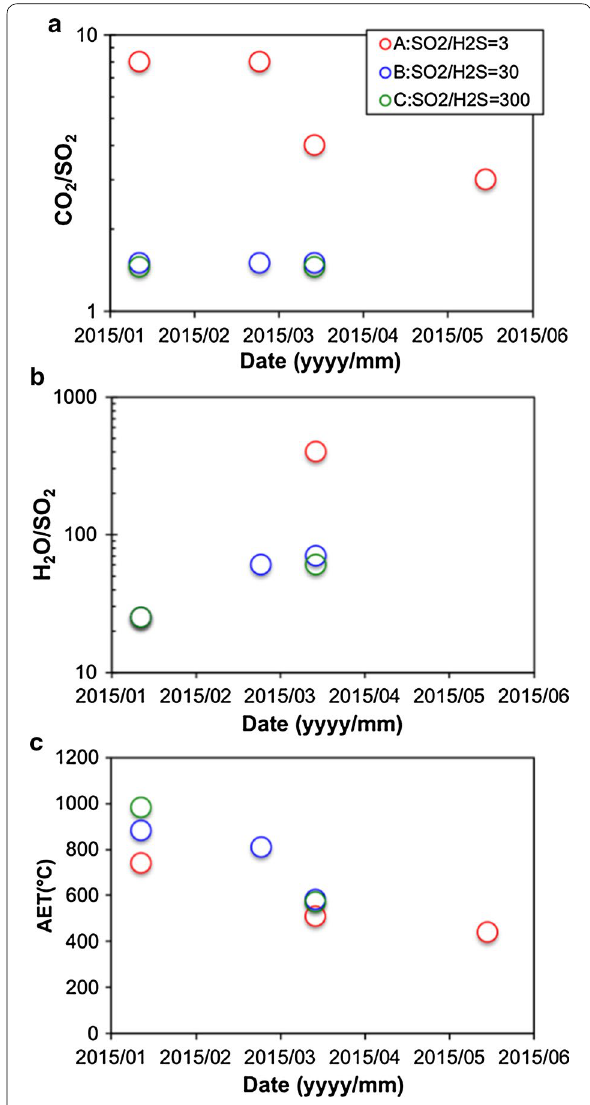
Fig. 11 Variation of the representative compositions of A series (SO 2 / H 2 O 3; red), B series (SO 2 /H 2 S 30; blue) and C-series (SO 2 /H 2 S = = 300; green). a CO 2 /SO 2 molar ratio, b H 2 O/SO 2 molar ratio, and d = apparent equilibrium